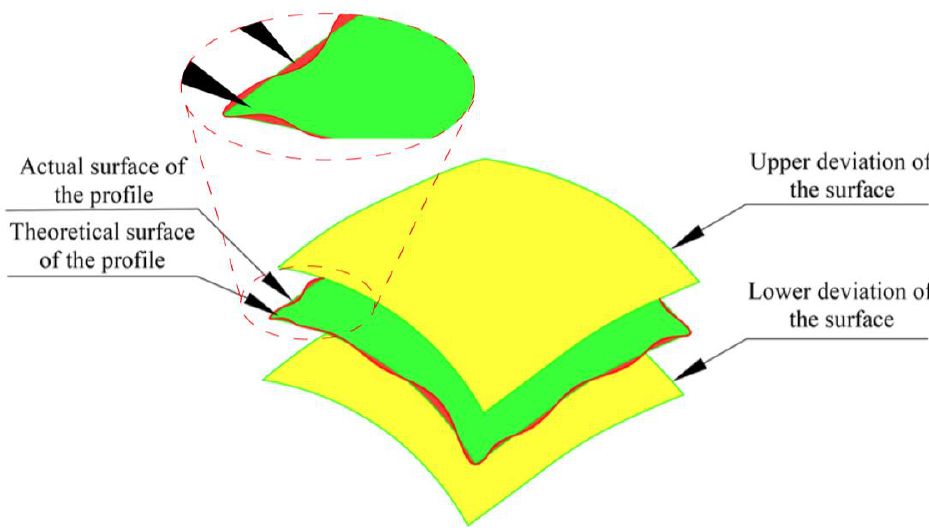
Figure 7. Schematic diagram of surface profile errors.